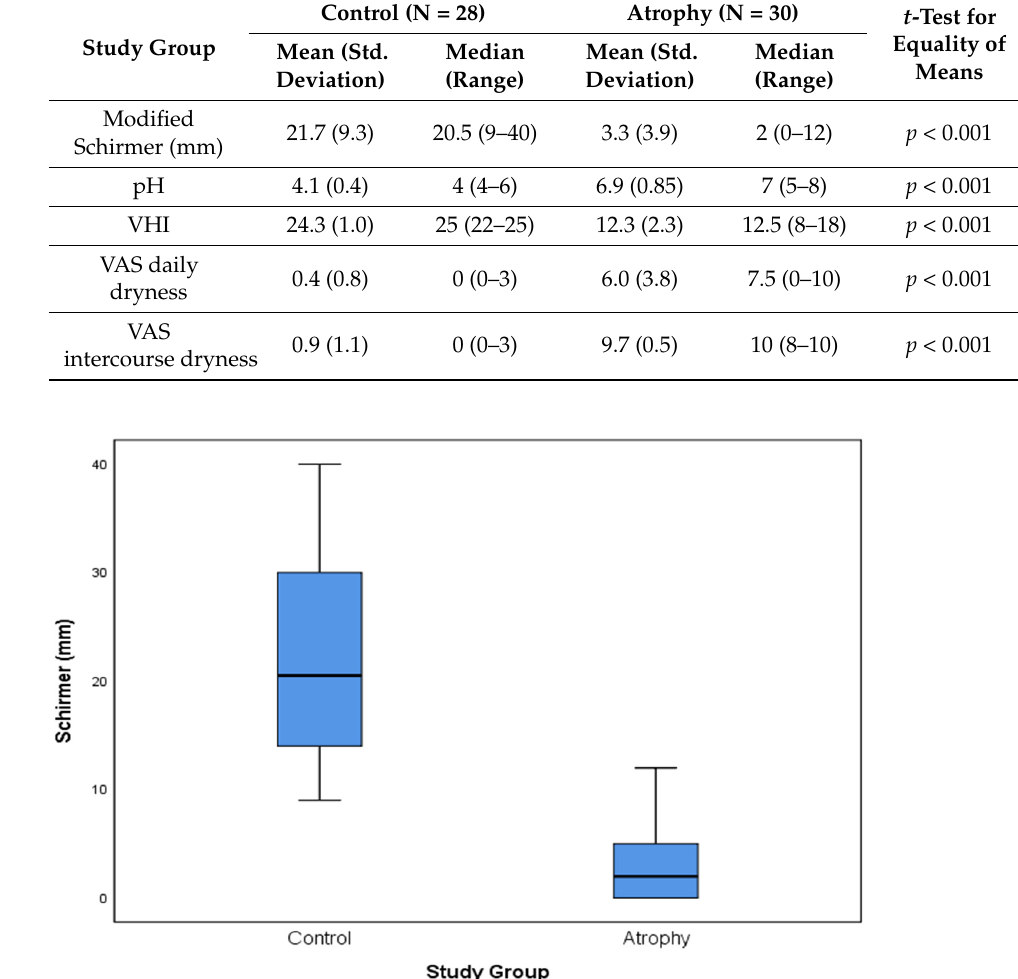
Figure 3. Modified Schirmer measurements in control and study groups. The figure graphically presents the differences between “modified Schirmer test” measurements in the control and the GSM groups. The horizontal line within the box indicates the median, boundaries of the box indicate the 1st and 3rd quartile, and whiskers indicate the minimum and maximum values.